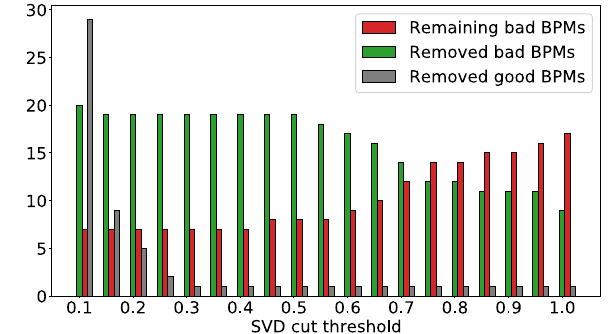
FIG. 7. Number of removed and remaining bad BPMs after applying SVD depending on SVD cut